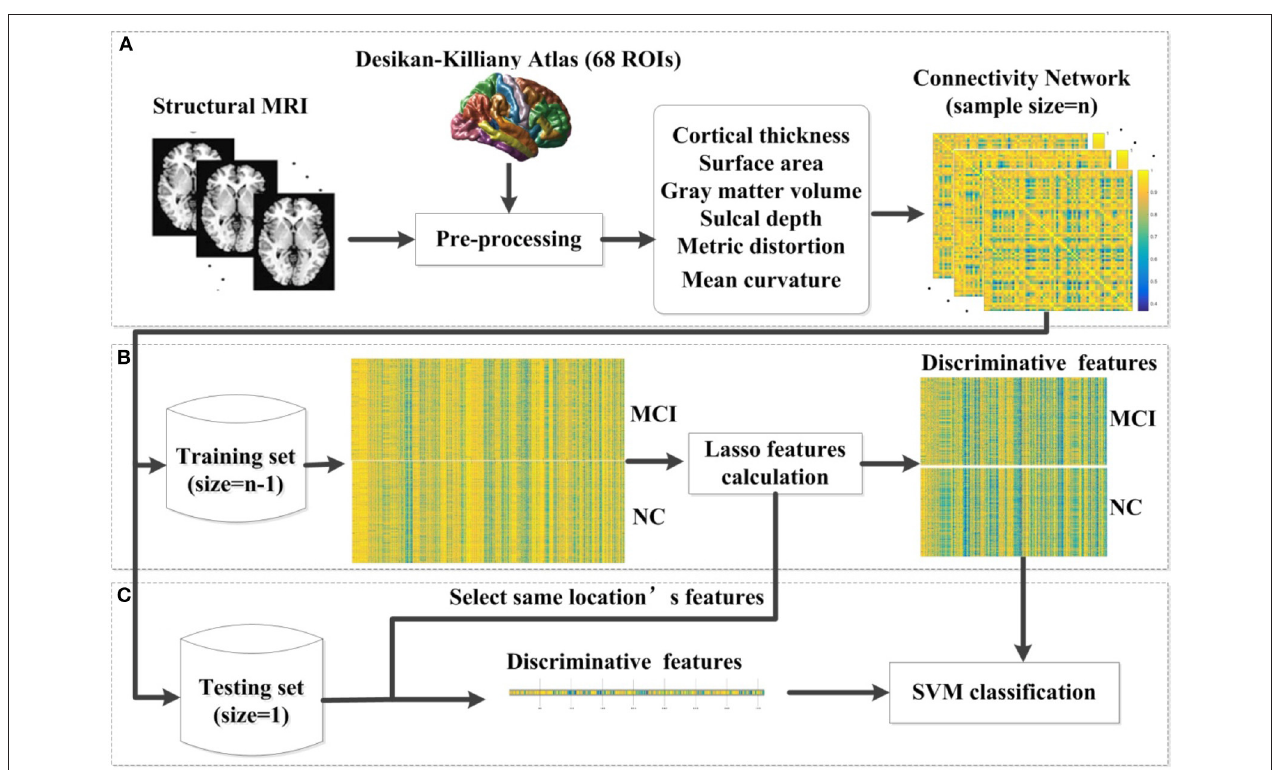
FIGURE 1 | The proposed classification framework. (A) The step of pre-processing was accomplished using FreeSurfer. For each vertex in each region, six morphological features were extracted. After the pre-processing, we constructed an individual brain network based on the multivariate Euclidean distance. (B) In each LOOCV classification, we first constructed the combination of the training set, and then applied the lasso features calculation for feature selection. (C) We selected the same location’s features in the testing set. Then the SVM classifier was implemented for classification. MCI, mild cognitive impairment; NC, normal controls; SVM, support vector machine; LOOCV, leave-one-out cross